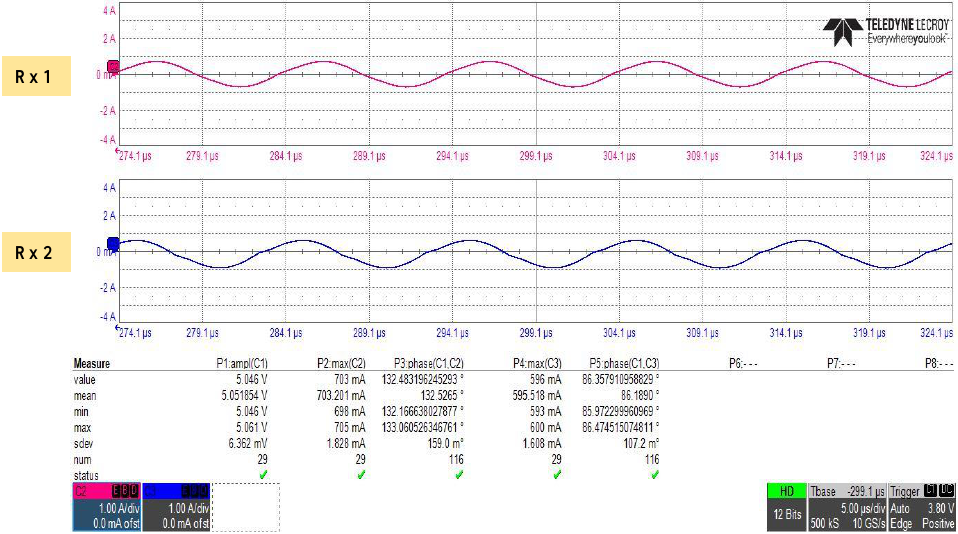
Figure 9. Measurement results for Rx coil current when 1 W of power is received. Table 2. Consumed power at the primary side and Rx